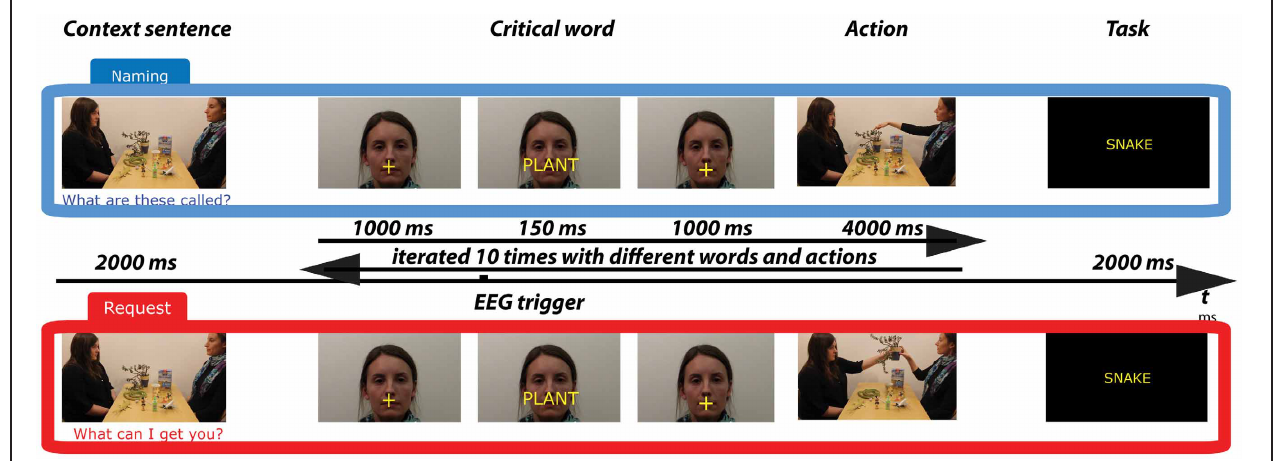
the critical word-utterance (naming vs. requesting an object), followed by an action (handing over or pointing at the object), involving different words and objects. The trial sequence finishes with a task to press a button (yes-no) if the test word shown on the screen has appeared in the trial.